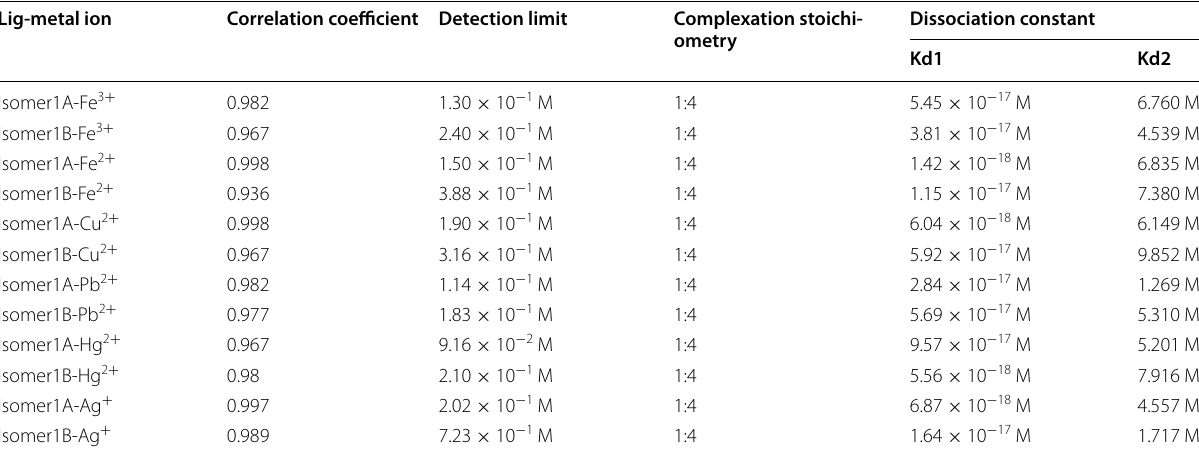
Table 4 Correlation coefficient, detection limit, stoichiometry of complexation and binding constants of both